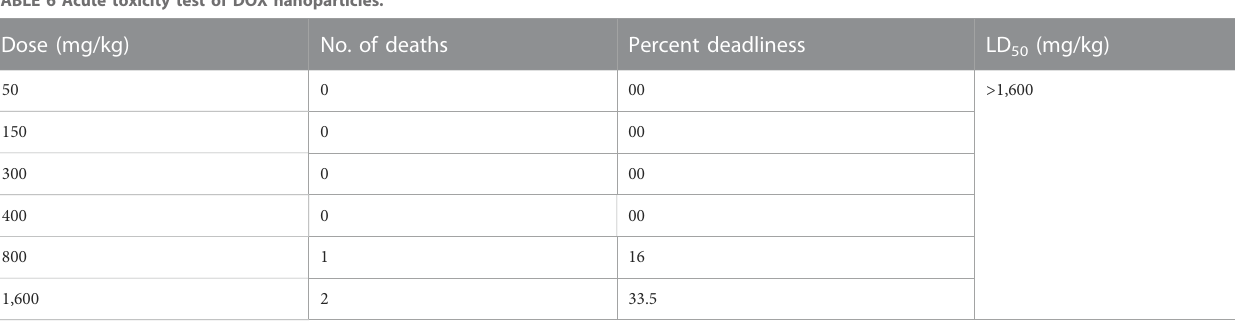
TABLE 6 Acute toxicity test of DOX nanoparticles. Dose